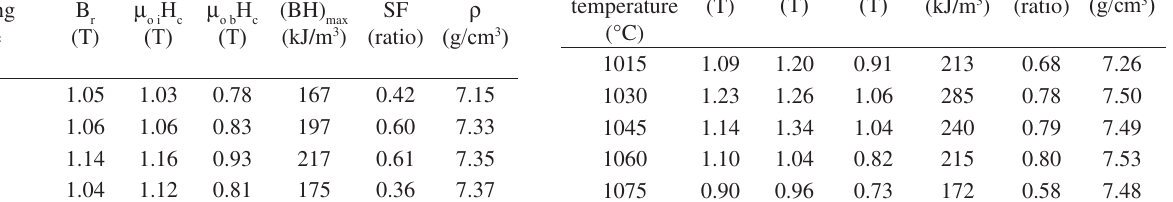
Table 2. Magnetic properties and density of Pr pared using powders milled for various times and sintered at 1060 °C (error: ± 2%).